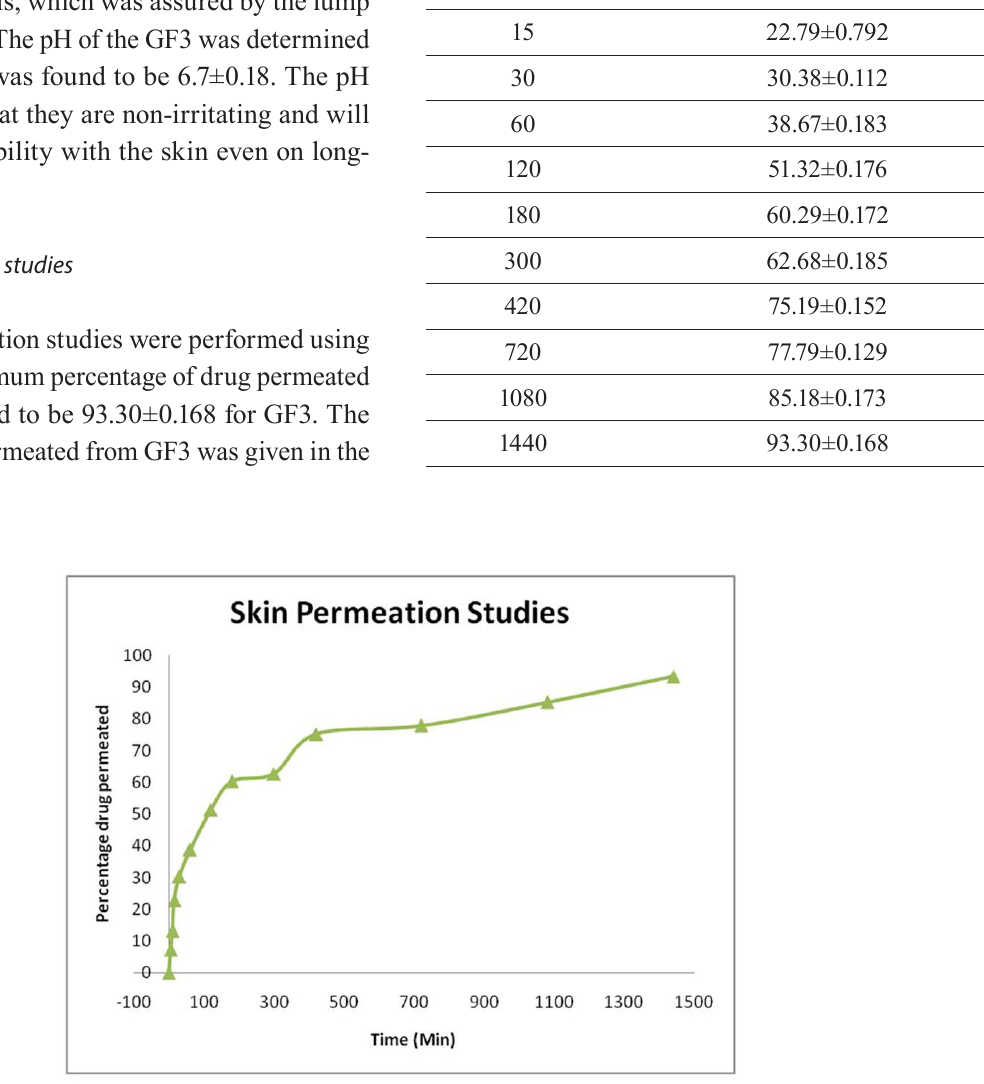
FIGURE 6 -: Skin Permeation study report of